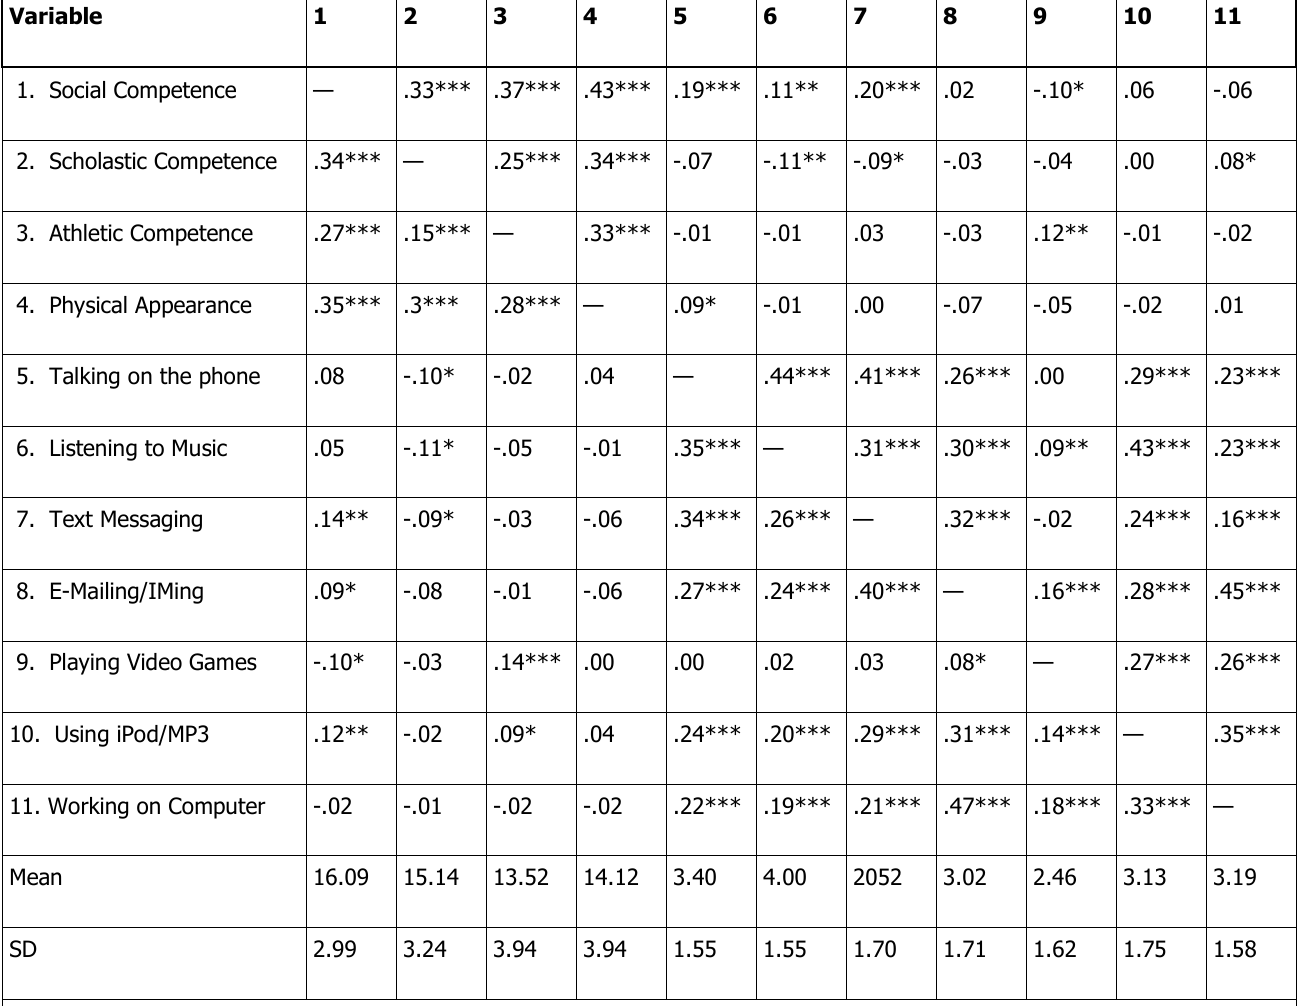
Means, Standard Deviations, and Correlations between the Study Variables